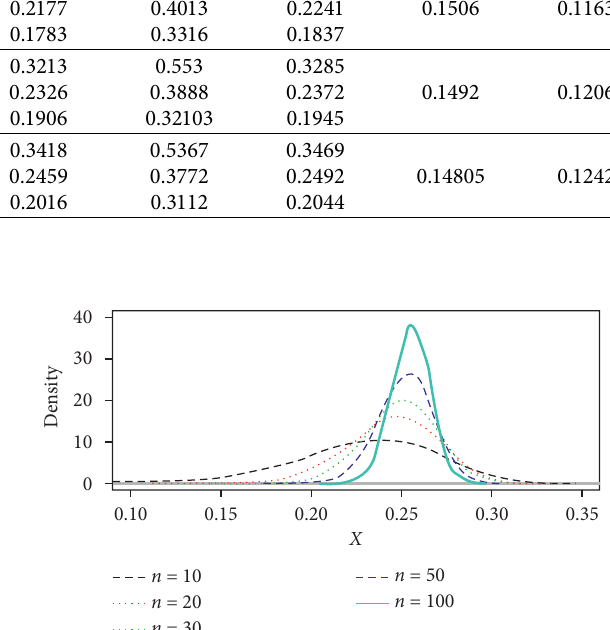
n based on U (0, 1).